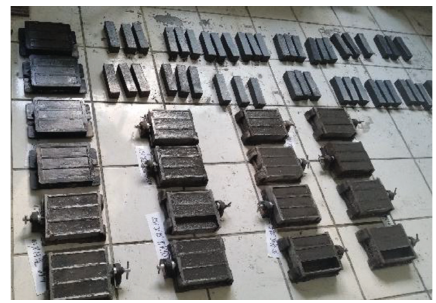
Figure 1: Preparation of concrete specimens.